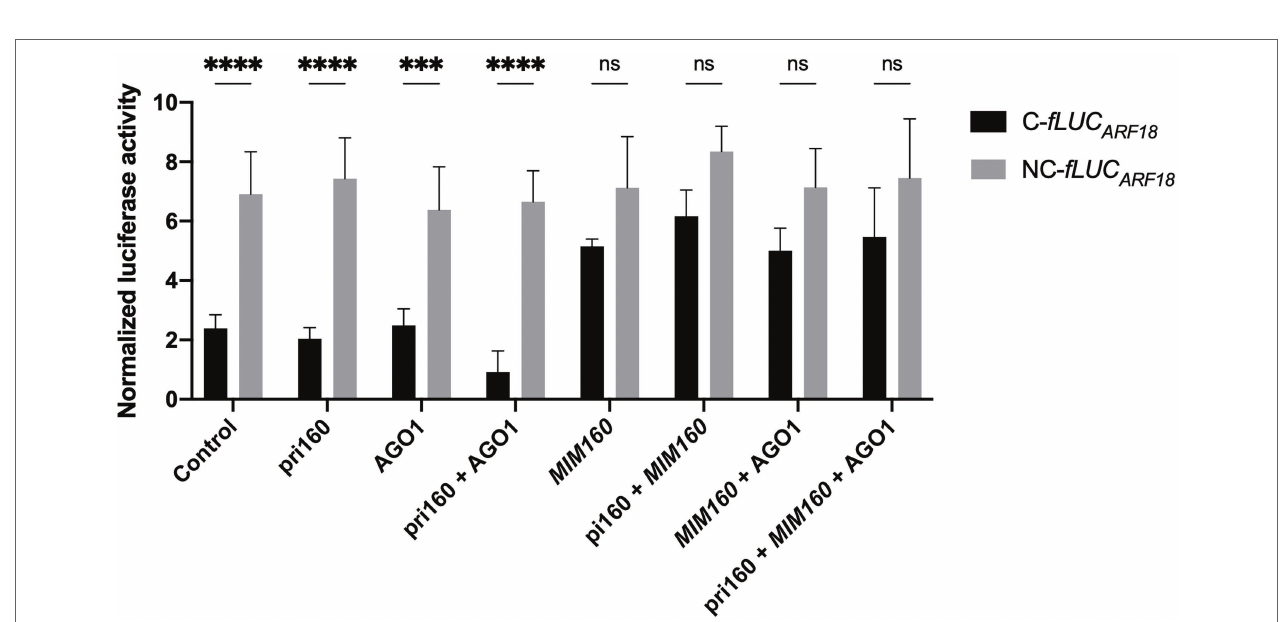
FIGURE 4 | Normalized luciferase activity from reporter constructs as a measure of miR160 activity in Arabidopsis protoplasts transfected for overexpression of the indicated elements. Asterisks (*) represent significant differences according to p value classification ( p < 0.001) obtained by two-way ANOVA and Sidak’s multiple comparison test. Bars of all graphics represent mean ± SE of four independent experiments with two technical replicates